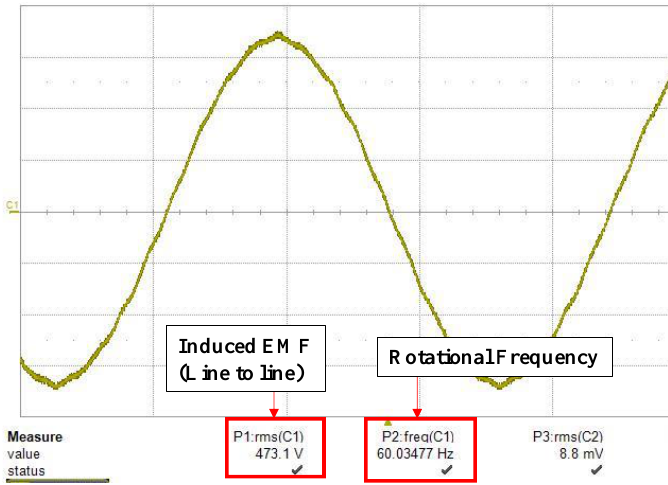
Figure 20. Measured wave form of the induced EMF at no-load drive.